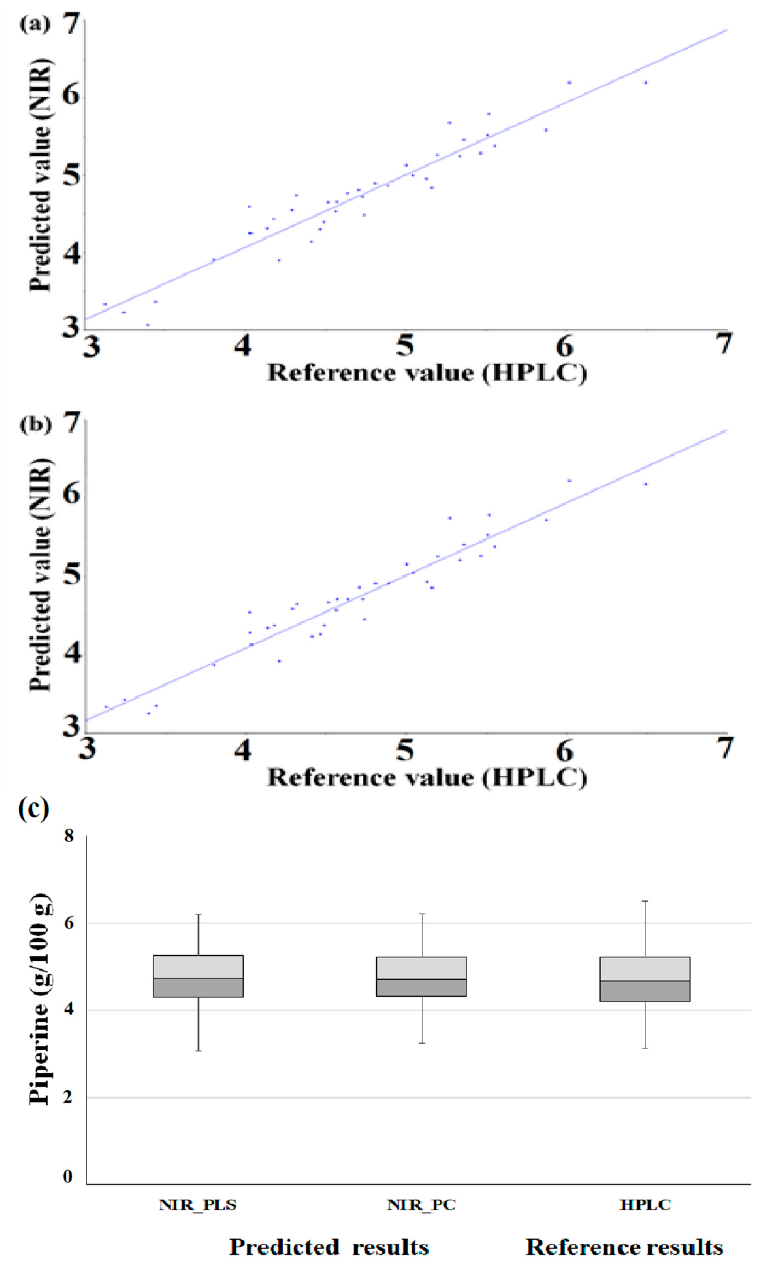
Figure 4. Method accuracy of developed regression (scatter plot of prediction model by optimized PLS ( a ) and PC ( b ) regression (g/100g), box plot ( c )).